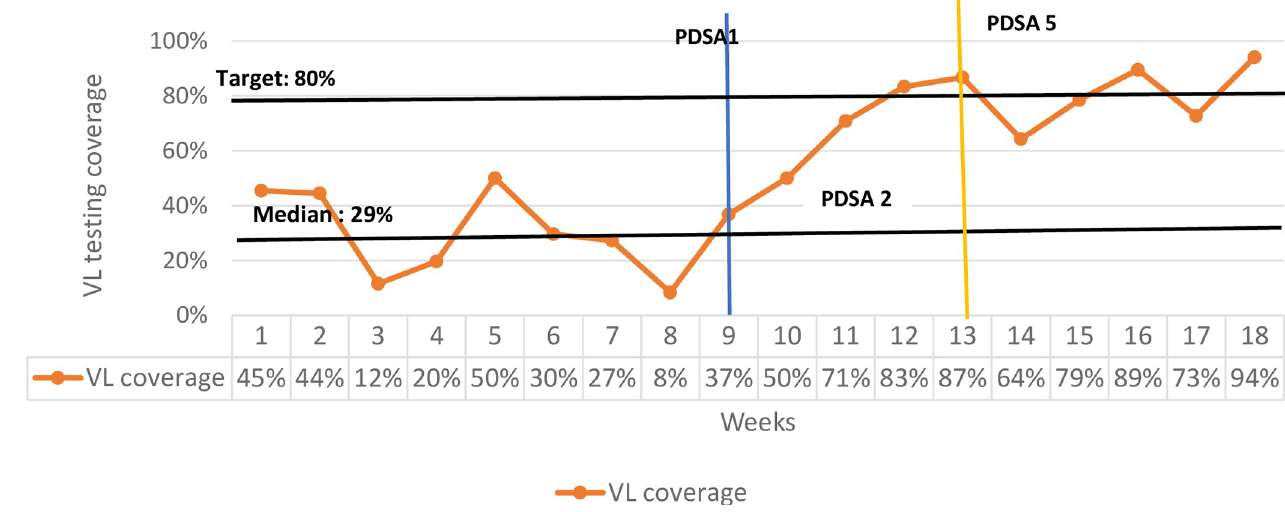
Fig 4. Run chart of VL testing coverage at Chilomoni health center in